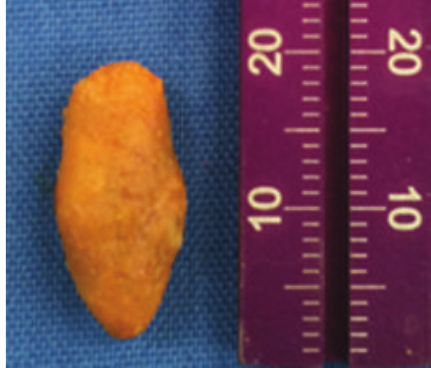
Figure 2: Clinical view of the sialolith after surgical removal.